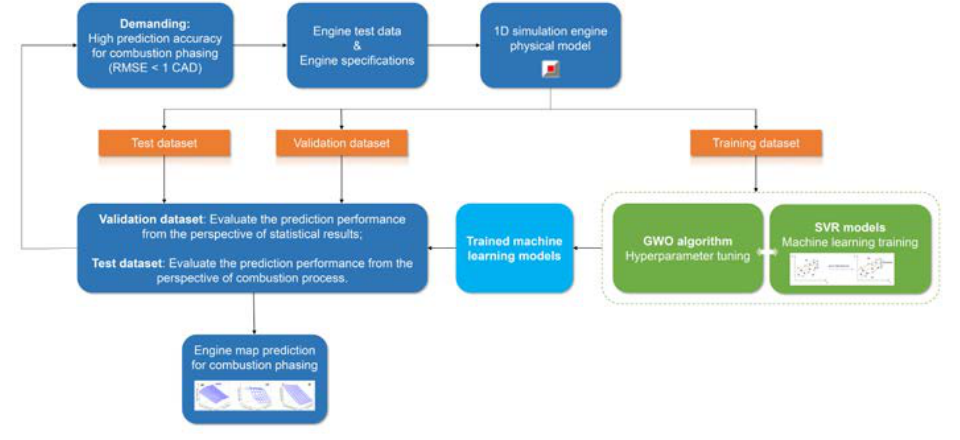
Figure 2. The flow chart of this